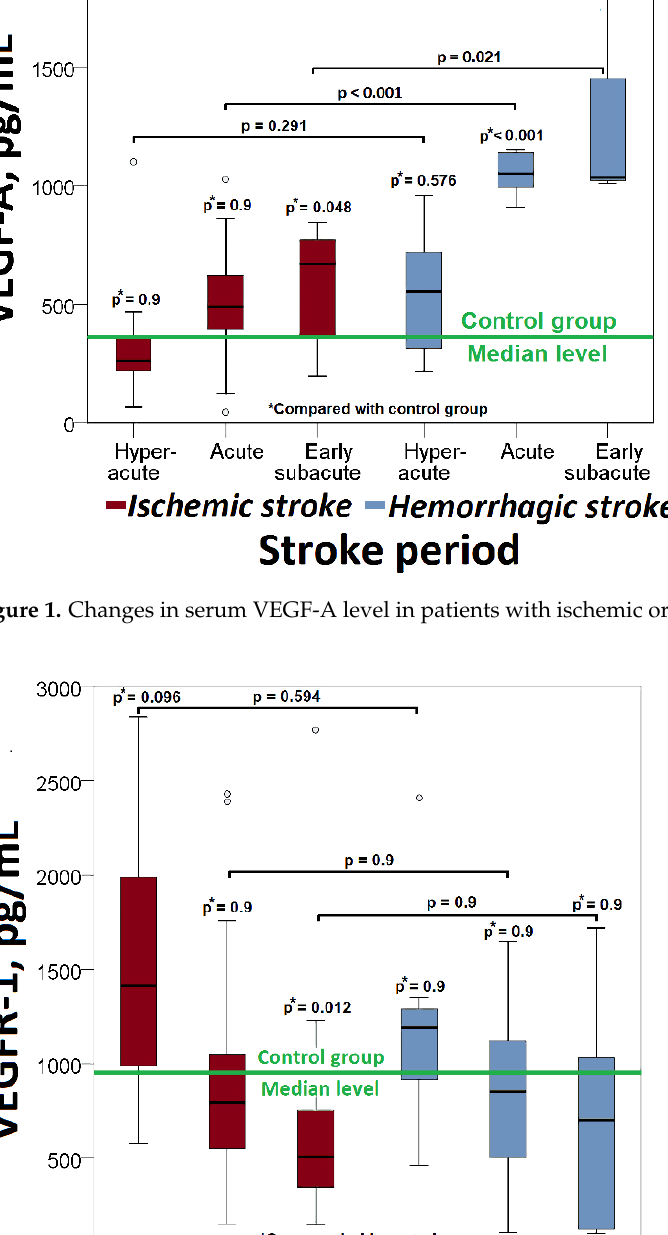
Curr. Issues Mol. Biol. 2022 , 44